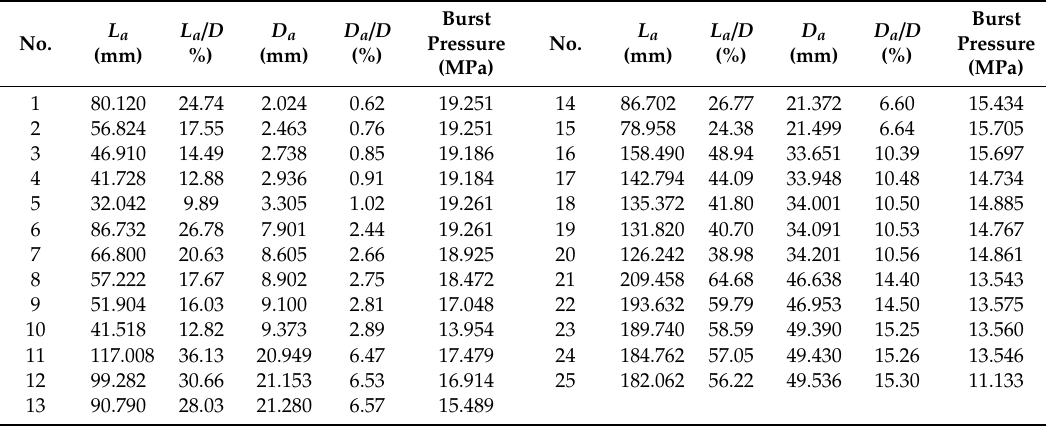
Table A4. La , La / D , Da , Da / D and burst pressure for the FEA based parametric study (II) for X80 material pipelines with a hemispherical